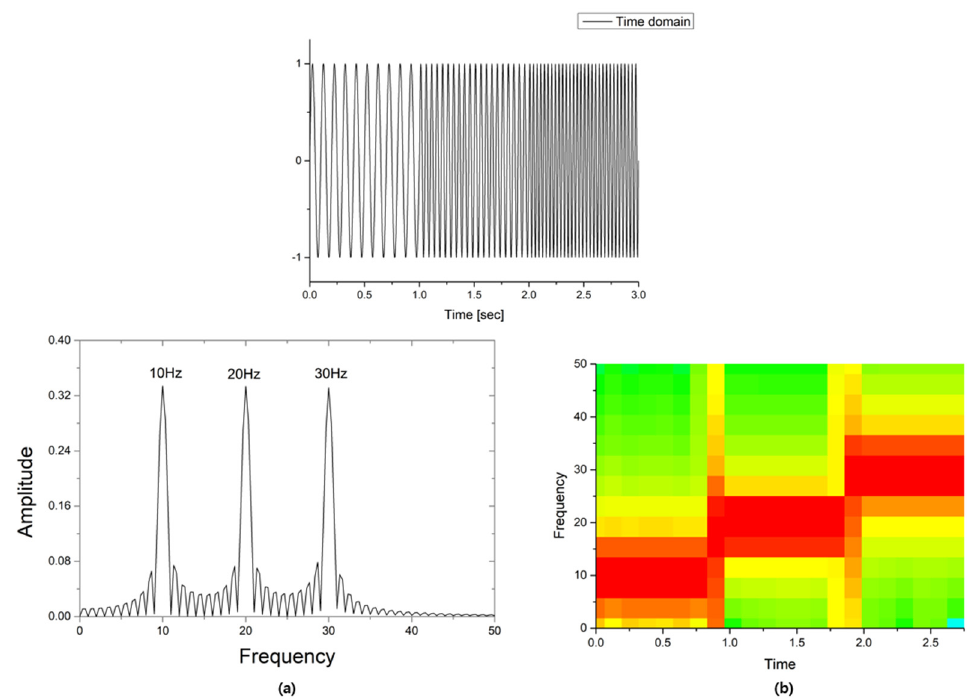
Figure 13. Difference between ( a ): FFT and ( b ): STFT [17].